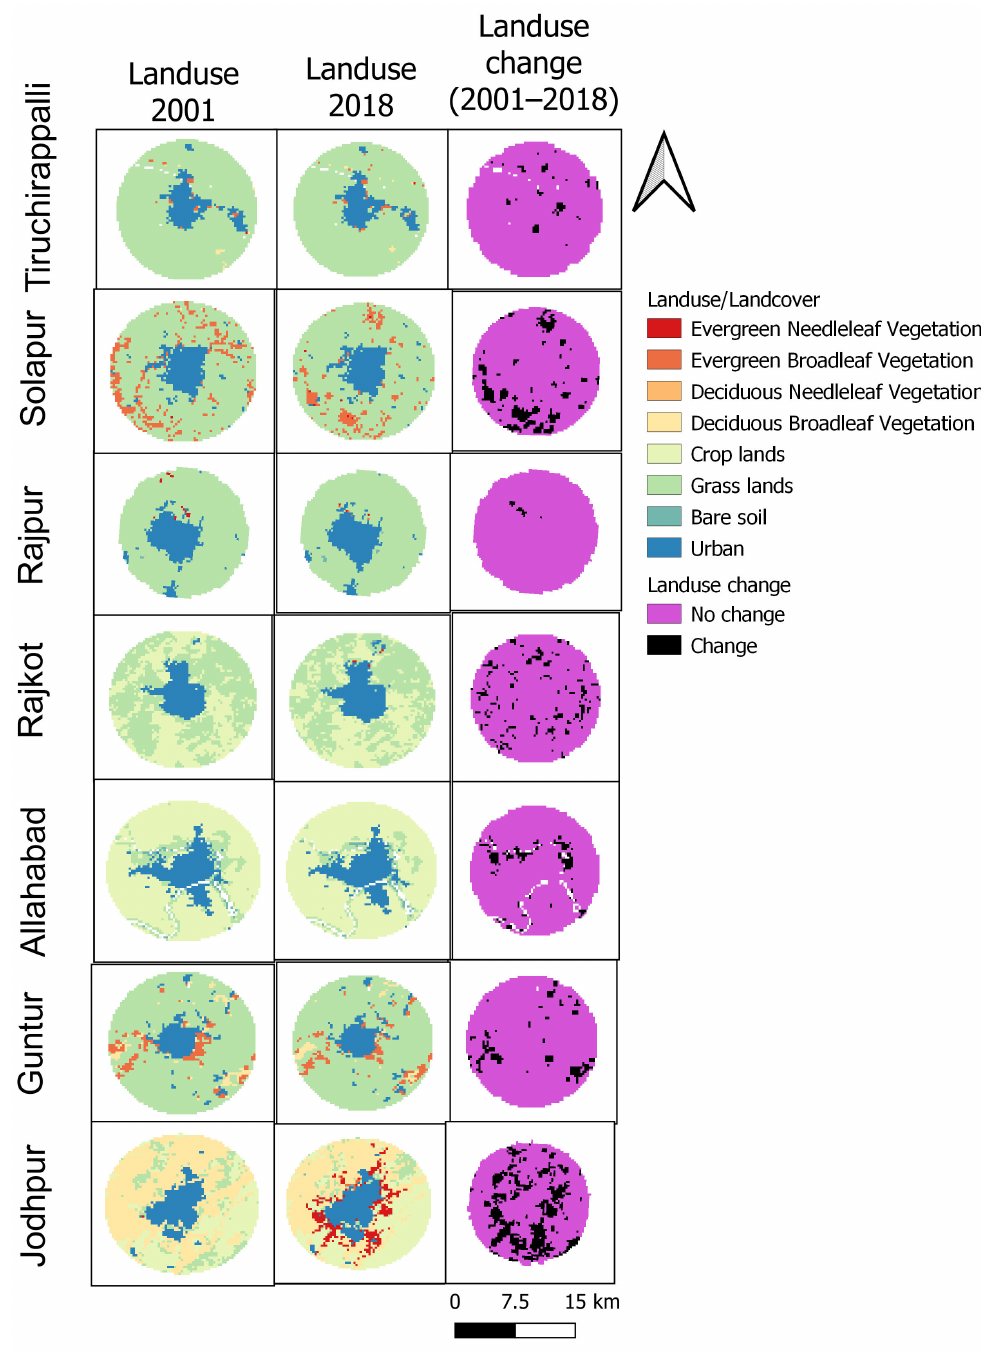
Figure 9. Land Use / Land Cover (LULC) changes in the selected